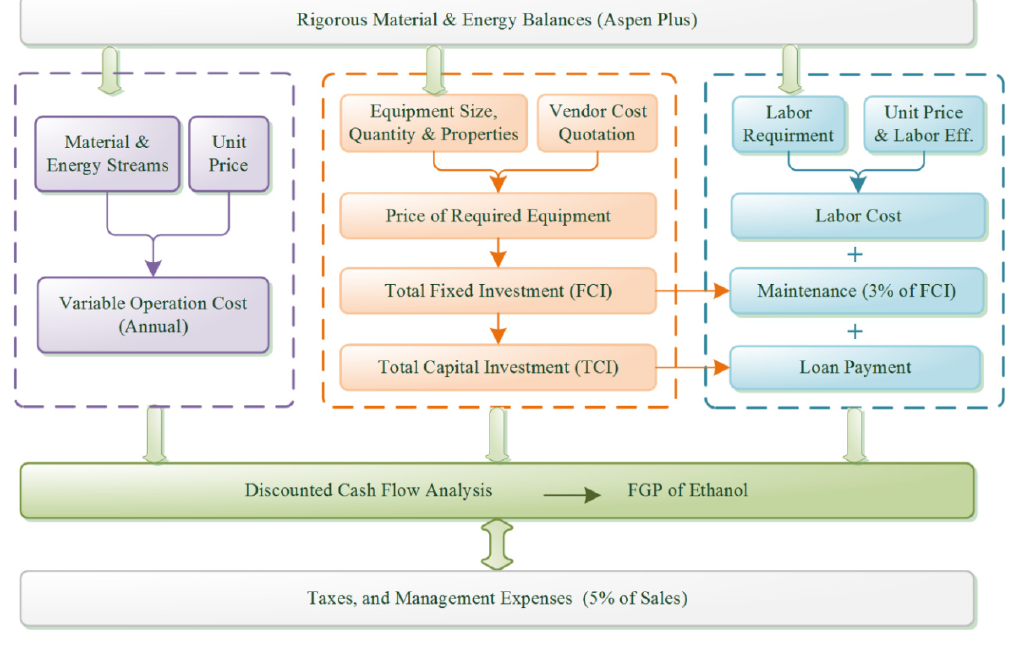
Figure 2. Techno-economic analysis